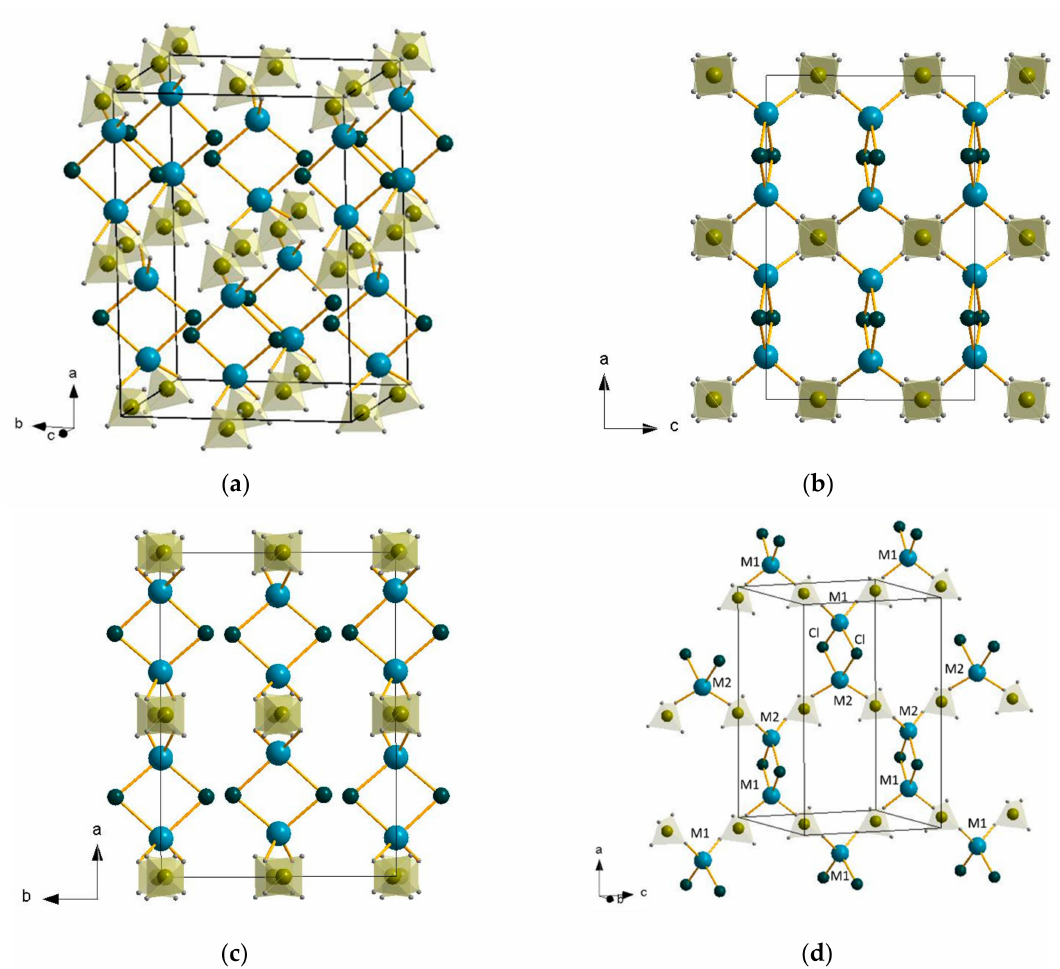
Figure 3. Unit cell of the LiAl(BH 4 ) 2 Cl 2 compound ( a ) in a–c ( b ) and a–b ( c ) directions. Representation of the coordination of atomic groups in unit cell( d ) (M1 and M2 atoms represent cation, which consists of Li and Al atoms, partially occupying the 4a positions (Table